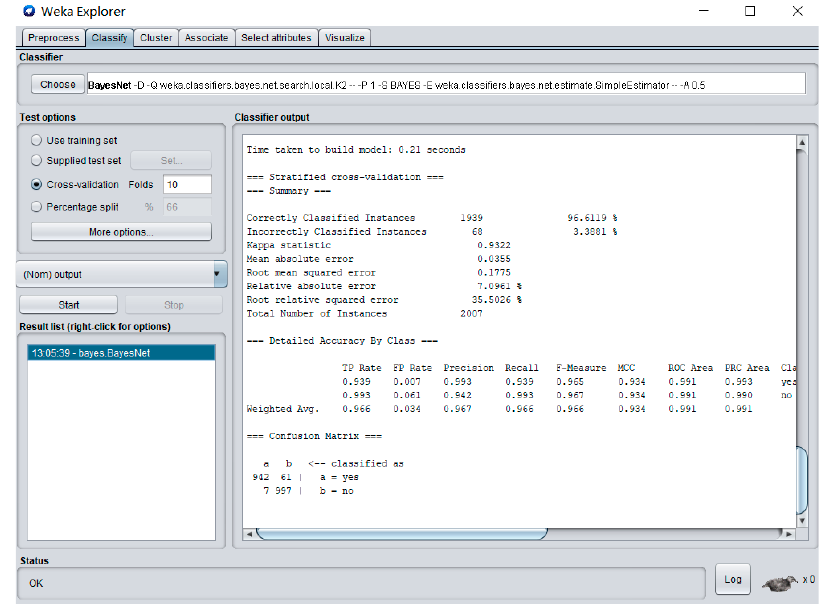
Figure 3. The interface of training naive Bayesian classifier using Weka